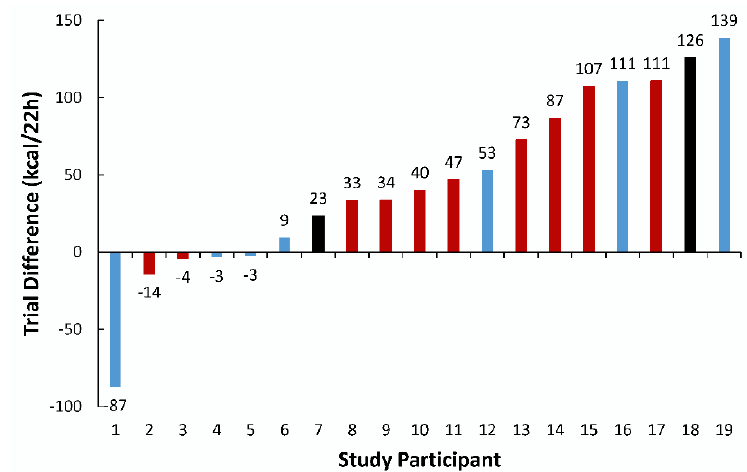
Figure 3. Energy expenditure (kcal/22 h) trial difference (MFC minus placebo) for each study participant. Data are depicted in ascending order, with arbitrary identification numbers for study participants. Red bars indicate study participants with the homozygous genotype A/A of the single-nucleotide polymorphism (SNP) rs762551. Blue bars indicate study participants with the genotypes C/A and C/C (just one participant, #4). The black bars indicate two participants for genotypes that could not be determined. The trial difference in energy expenditure between those with genotype A/A, and those with genotypes C/A or C/C was not statistically significant (51.4 ± 42.8 and 31.3 ± 82.1 kcal/22 h, respectively, p = 0.50).